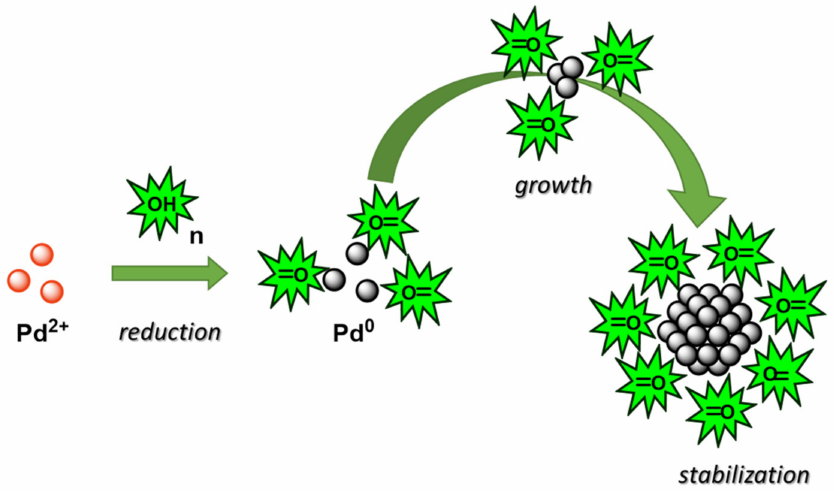
Figure 3. PdNPs formation by plant extract reduction and